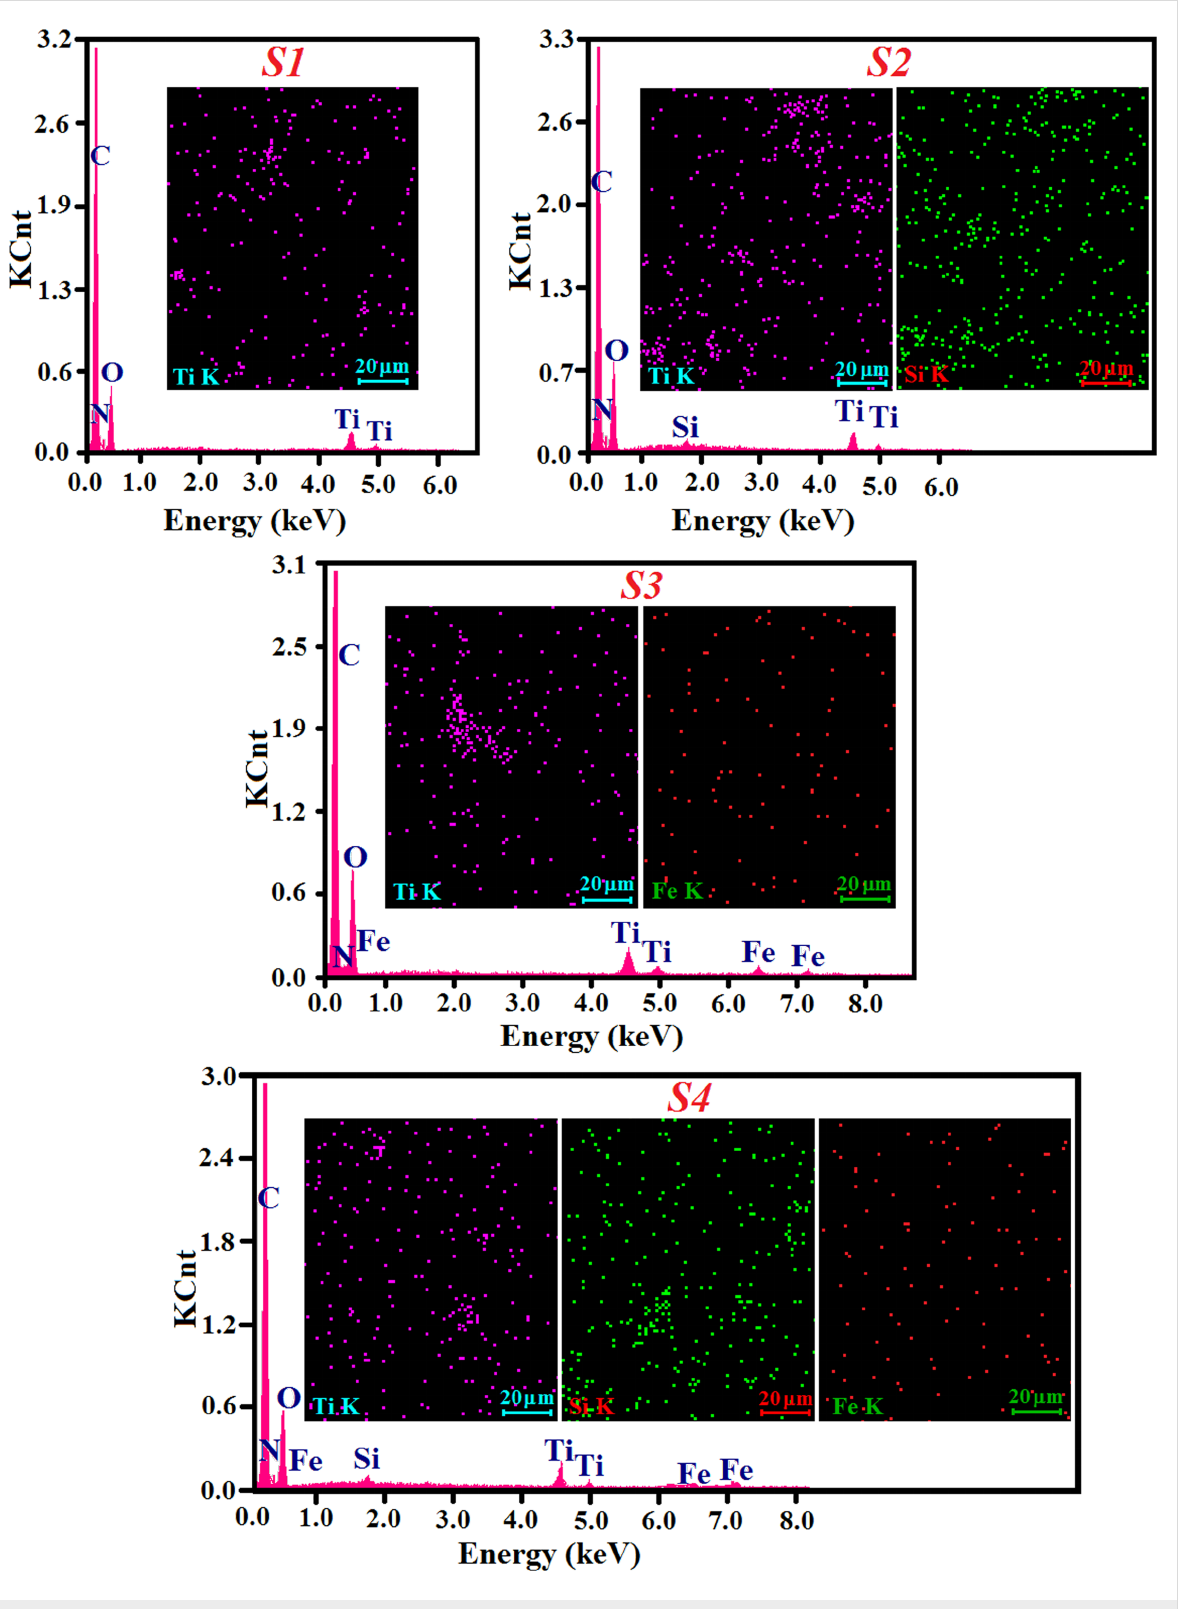
Figure 3: EDX spectra of S1–S4 hybrid composites recorded in cross section and mappings of titanium, silicon and